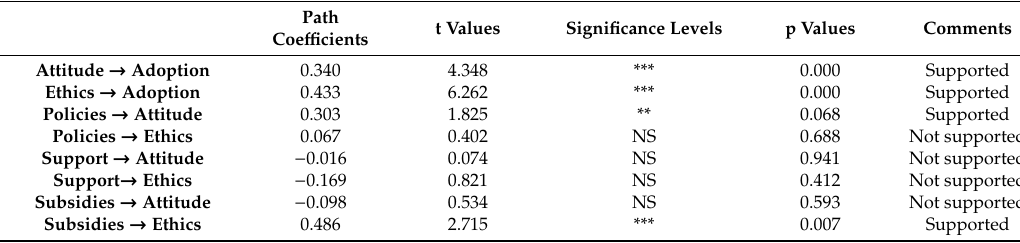
Table 3. Results of the structural model path coe ffi